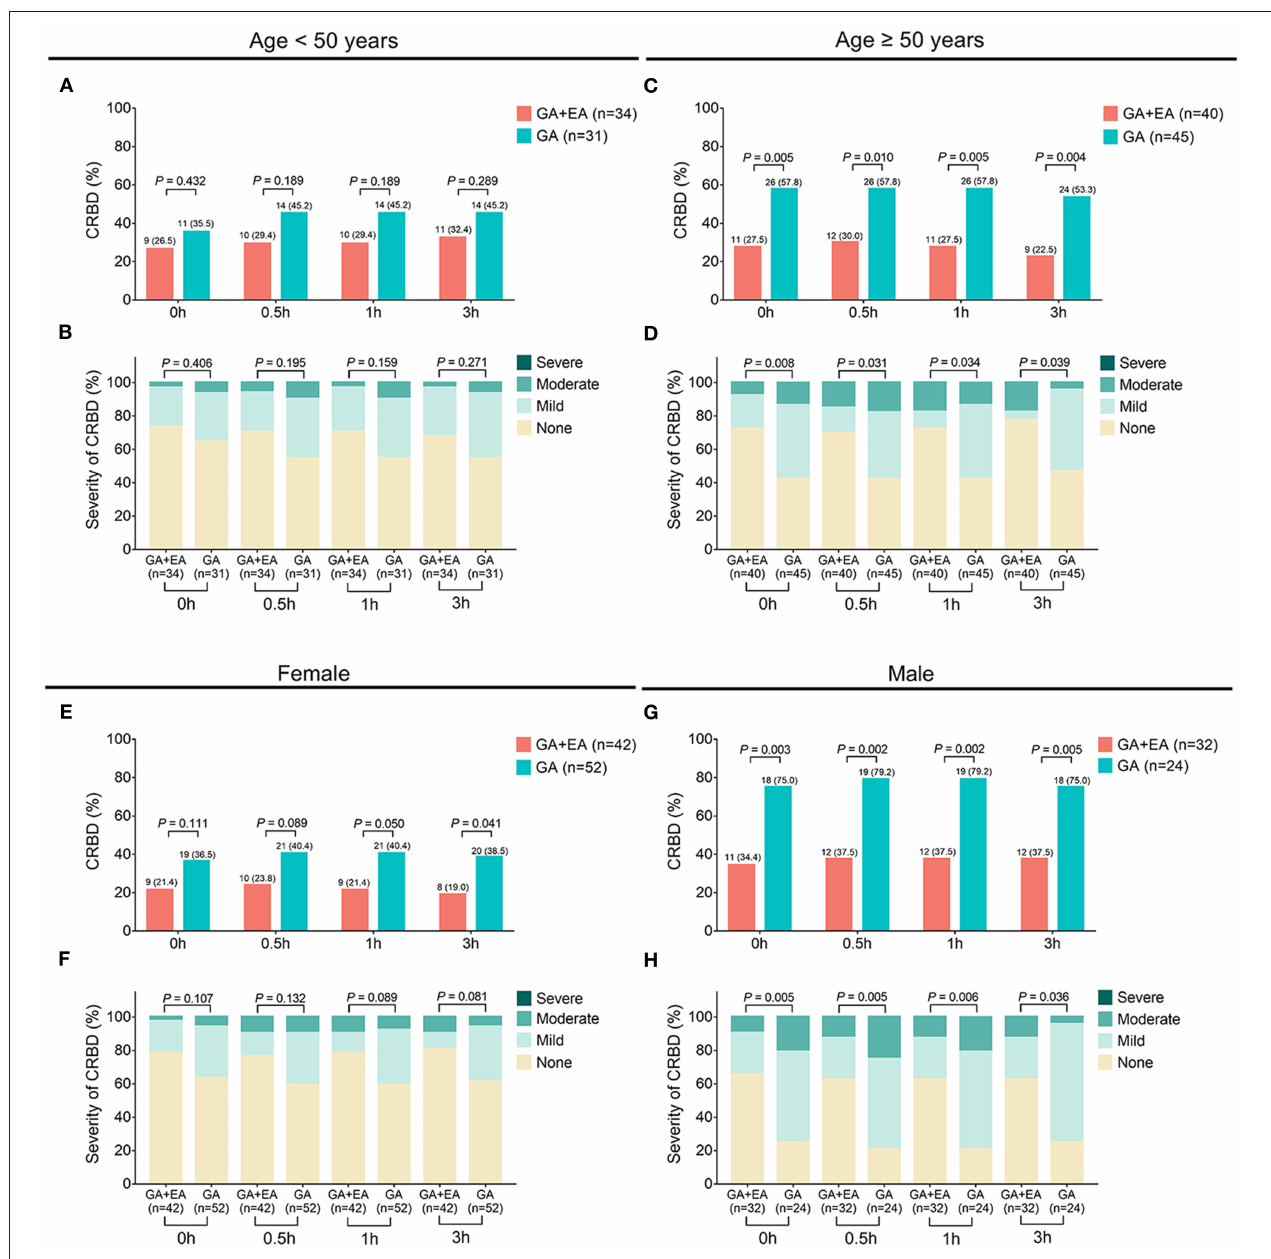
FIGURE 3 | Occurrence and severity of CRBD in subgroups. Comparison of the occurrence (A) and severity (B) of CRBD between GA + EA group and GA group in patients younger than 50 years; Comparison of the occurrence (C) and severity (D) of CRBD between GA + EA group and GA group in patients equal to or older than 50 years; Comparison of the occurrence (E) and severity (F) of CRBD between GA + EA group and GA group in female patients; Comparison of the occurrence (G) and severity (H) of CRBD between GA + EA group and GA group in male patients. CRBD, catheter-related bladder discomfort; GA, general anesthesia; EA, epidural anesthesia; h,